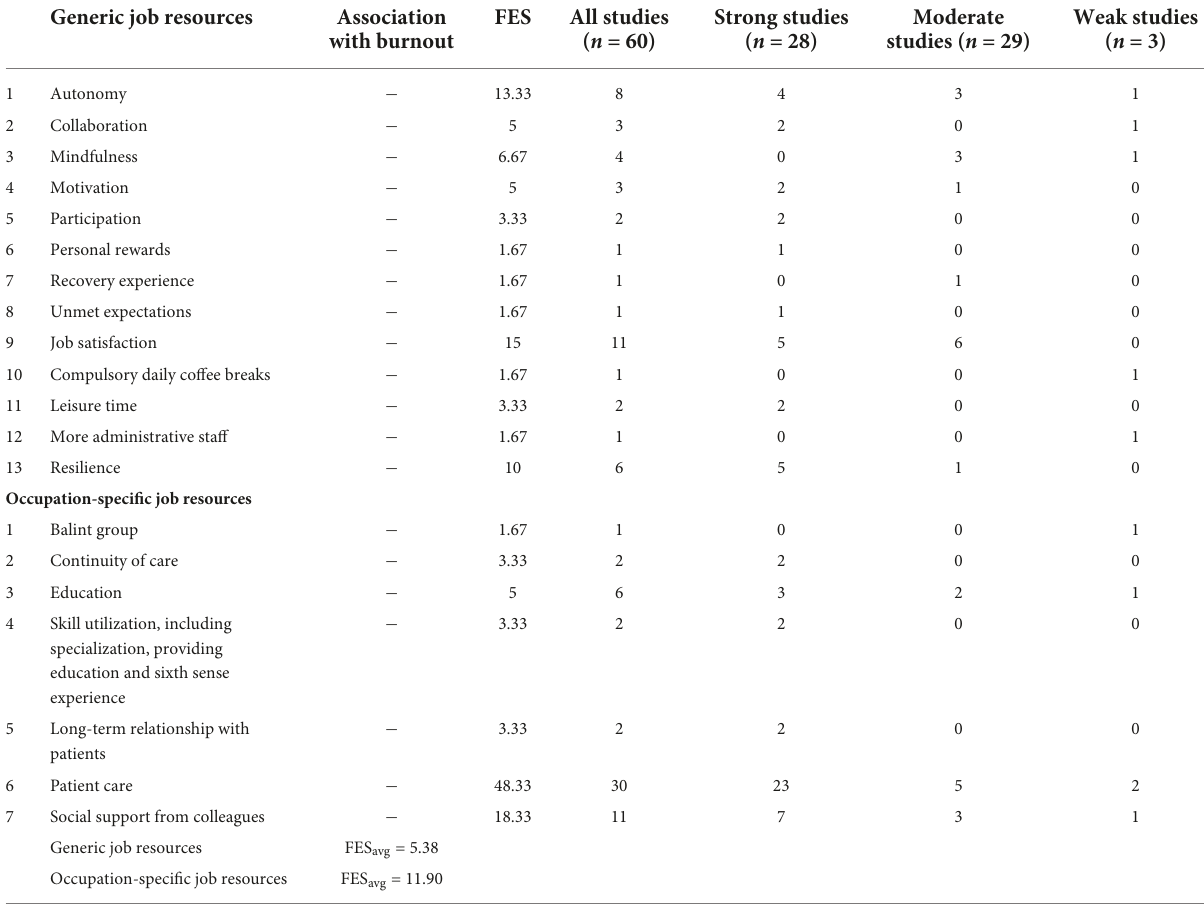
TABLE 3 Study outcomes job resources.